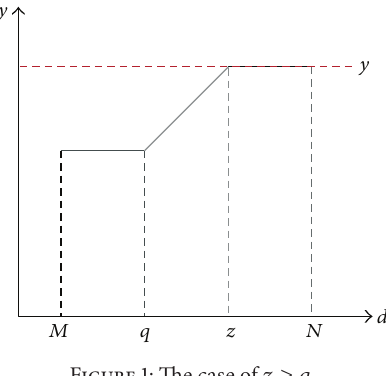
Figure 1: The case of 𝑧 ≥ 𝑞